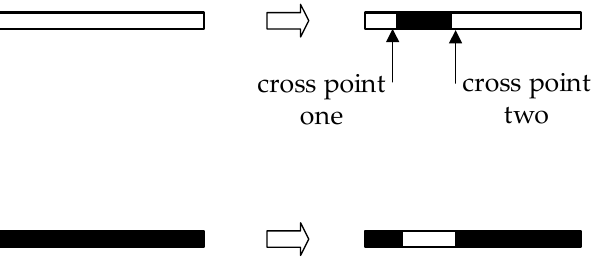
Figure 5. Principle of the two-point crossover operator used in this work.